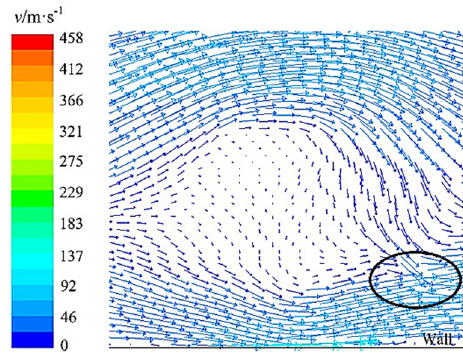
Figure 8. Velocity vector diagram at the moment of the bubble bursting.